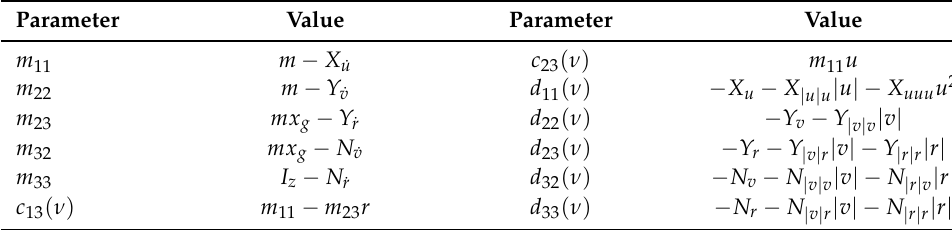
Table 1. Definitions of parameters in M , C , D .